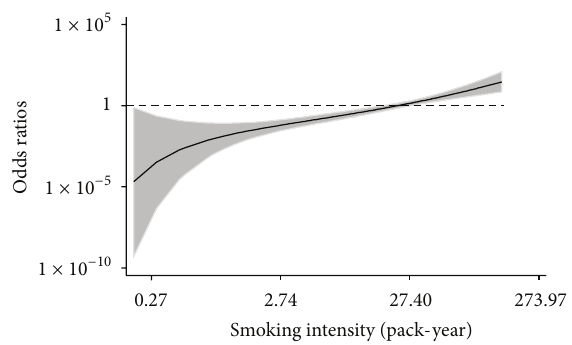
Figure2:Dose-dependenteffectofsmokingintensityon 𝛽 -celldefi- ciency. Fractional polynomial regression model is used to analyze the association between smoking intensity and 𝛽 -cell deficiency. Solid line represents odds ratios; shaded area shows 95% confidence interval; dash line indicates the